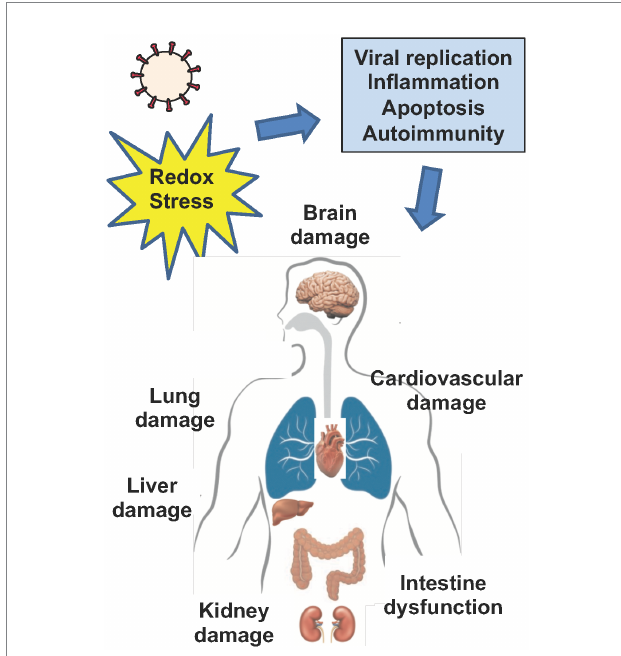
FIGURE 3 Viral infection and end organ damage. Increased redox stress drives viral replication, inflammation, apoptosis, vascular dysfunction and autoimmunity, in both acute infection with coronaviruses and in the setting of Post-Acute Sequelae of SARS-CoV-2 (PASC or Long COVID). Collectively, redox mediated pathways that drive viral replication, inflammation, apoptosis, autoimmunity, and vascular dysfunction contribute to cell and tissue damage that drives end organ disease in coronavirus infection. Cells enriched in mitochondria such as neurons, endothelial and epithelial cells may be particularly susceptible to increased redox stress driven by coronaviruses. Ultimately, increased redox stress during acute infection with coronaviruses and in the setting of PASC can directly or indirectly drive end organ disease such as brain, lung, liver, kidney and cardiovascular damage and induce intestinal